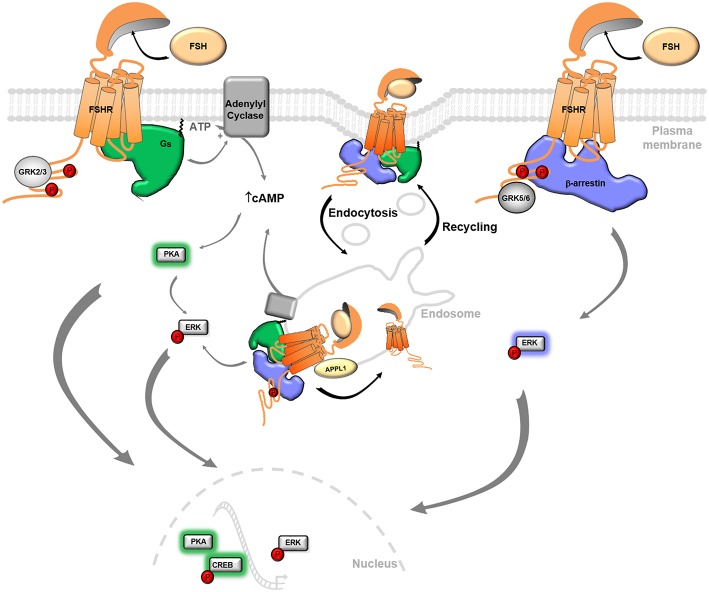
FSHR signaling and trafficking. Upon FSH binding, the FSHR mainly activates Gαs protein, leading to conversion of ATP to cAMP by adenylyl cyclases and activation of intracellular effector kinases, including PKA. After stimulation, GRK phosphorylates and desensitizes the FSHR. Phosphorylated FSHR recruits β-arrestin, which in turn induces its own signaling, including ERK activation, as well as receptor internalization in the endosomes. FSHR potentially activates G protein-dependent and -independent signaling from the endosomal compartment, before quickly recycling back to the plasma membrane. Effector proteins drive the cellular responses, including gene transcription, cell proliferation and differentiation. APPL1, Adaptor protein, phosphotyrosine interacting with PH domain and leucine zipper 1; CREB, cAMP response element binding protein; ERK, extracellular signal-regulated kinase; FSH, Follicle-stimulating hormone; GRK, G protein-coupled receptor kinase; PKA, protein Kinase A.